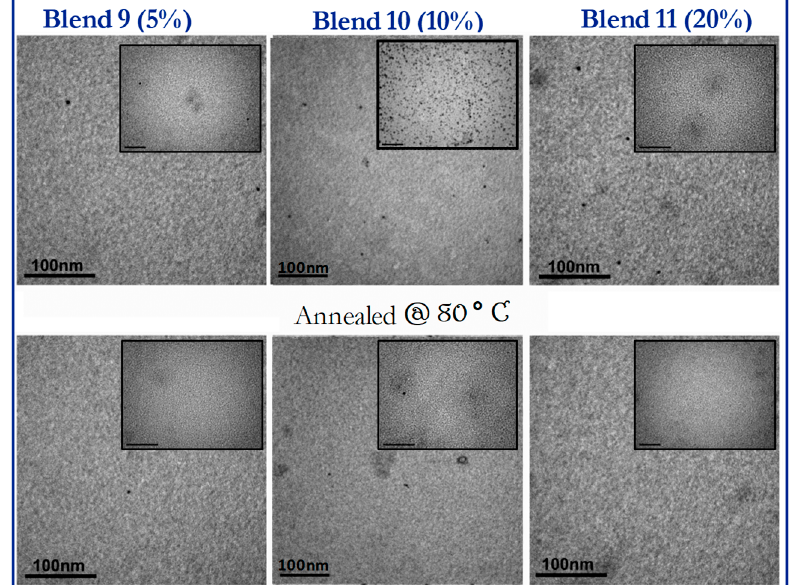
Figure 8. TEM images of a blends 2–4 (PCDTBT:PC 71 BM 1:1 w/w containing 5%, 10% and 20% wt of P3,6C(EH)DTBT-PQPy without annealing (top images) and after annealing at 80 °C (bottom images). For the bigger images, the scale bars correspond to 100 nm, while for the inset images, they correspond to 50 nm.